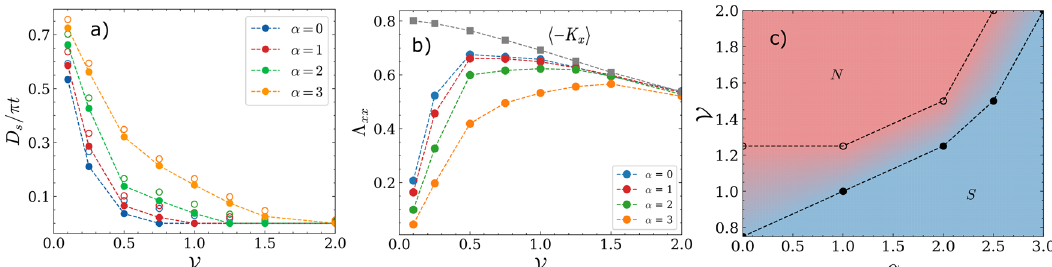
Fig. 6 Super fl uid stiffness and the phase diagram. a super fl uid stiffness D s (solid circles) as a function of V , calculated for selected values of α . The bare BCS stiffness D 0 s is shown by open circles for comparison. b Diamagnetic 〈 − K x 〉 and paramagnetic Λ xx ( q x = 0, q y = 0, i ω = 0) contributions to D 0 s are plotted as functions of V for several values of α . c The phase diagram of disordered superconductors in the plane α (cid:2) V . The blue S and red N regions denote the domains of non-zero and zero stiffness, respectively. Two crossover boundaries between the S and N domains are found using the fl uctuation-corrected D fi lled circles) and bare D 0 fl uid stiffness. The lines connecting the points are guides for s ( s (empty circles) super